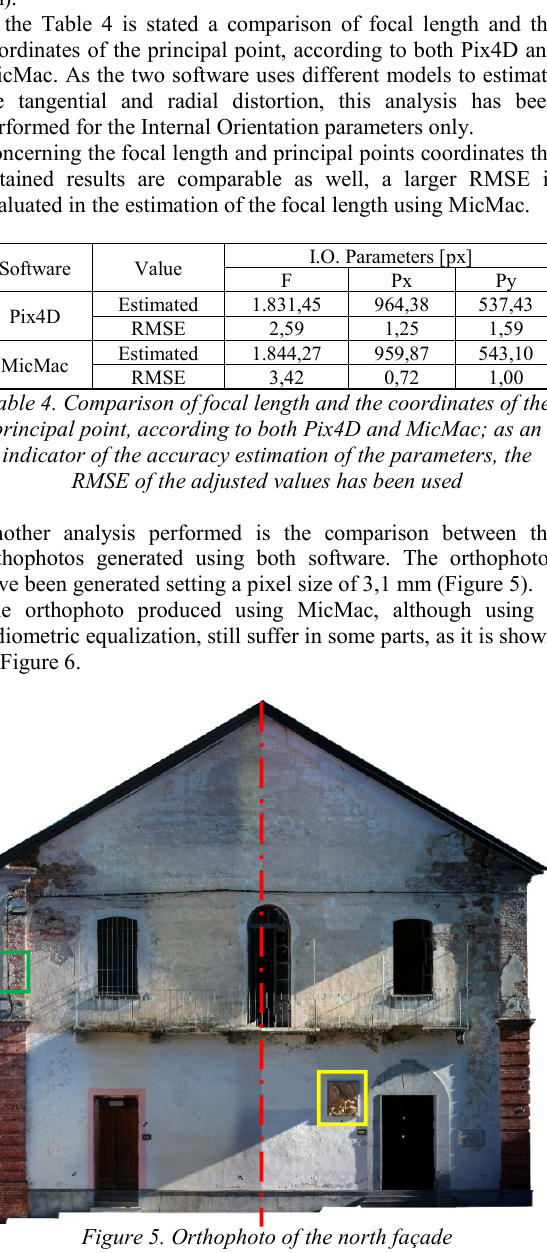
Figure 4. Map of the positions of the camera for the images captured with the flight ID n.3 of the DJI Spark (in green) and the position of the markers placed on the façade (in red).